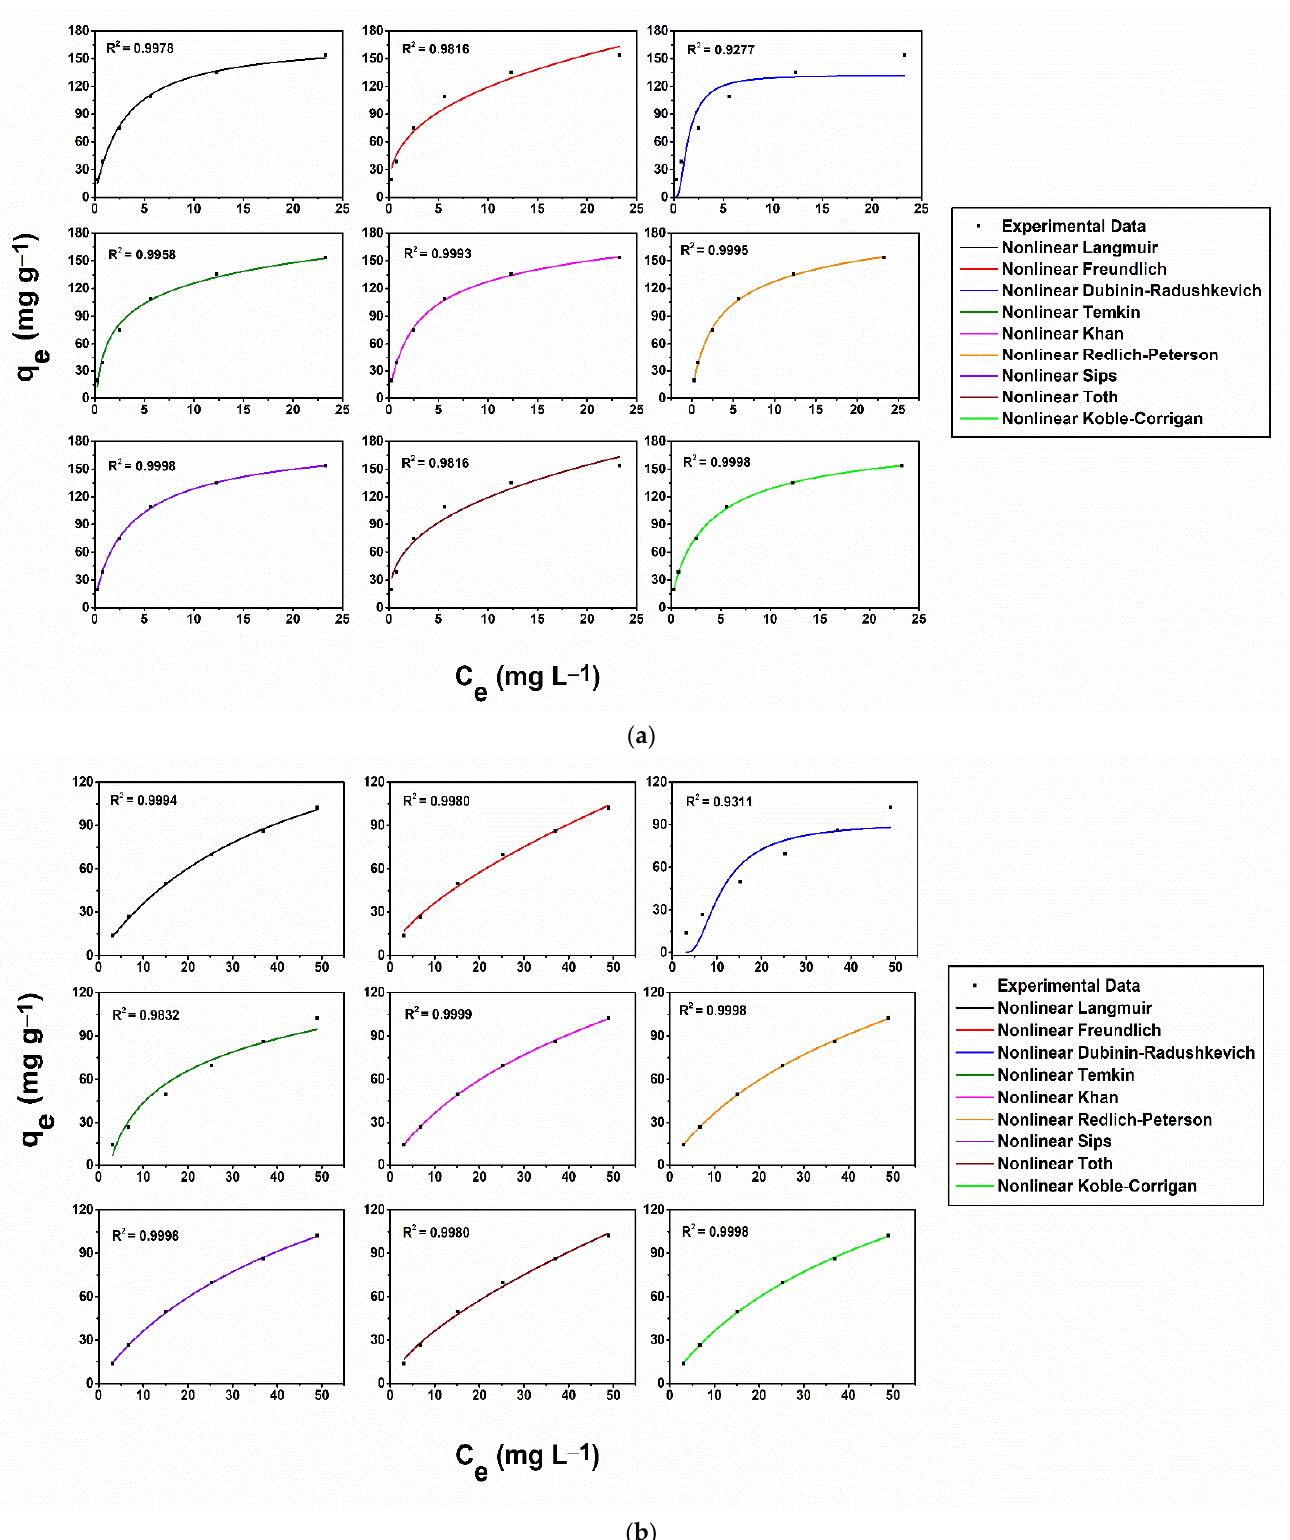
Figure 11. Nonlinear forms of the equilibrium isotherms obtained for ( a ) Pb and ( b ) Cd adsorption onto CHIT-PAAA.